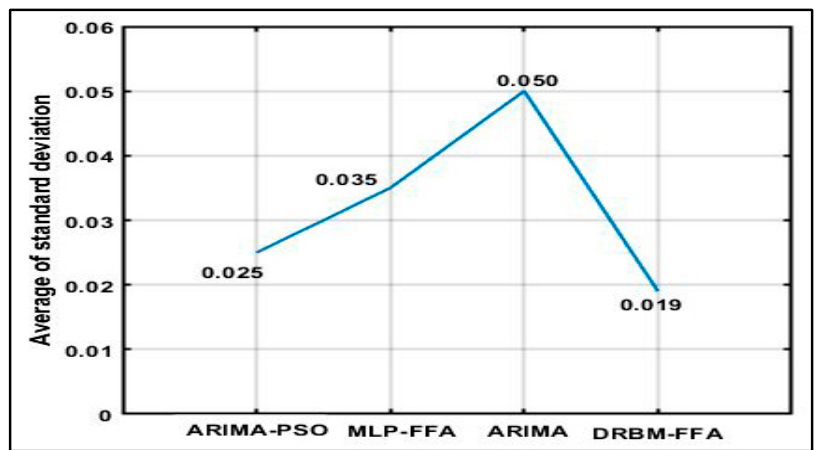
Figure 10. Average of standard deviation.